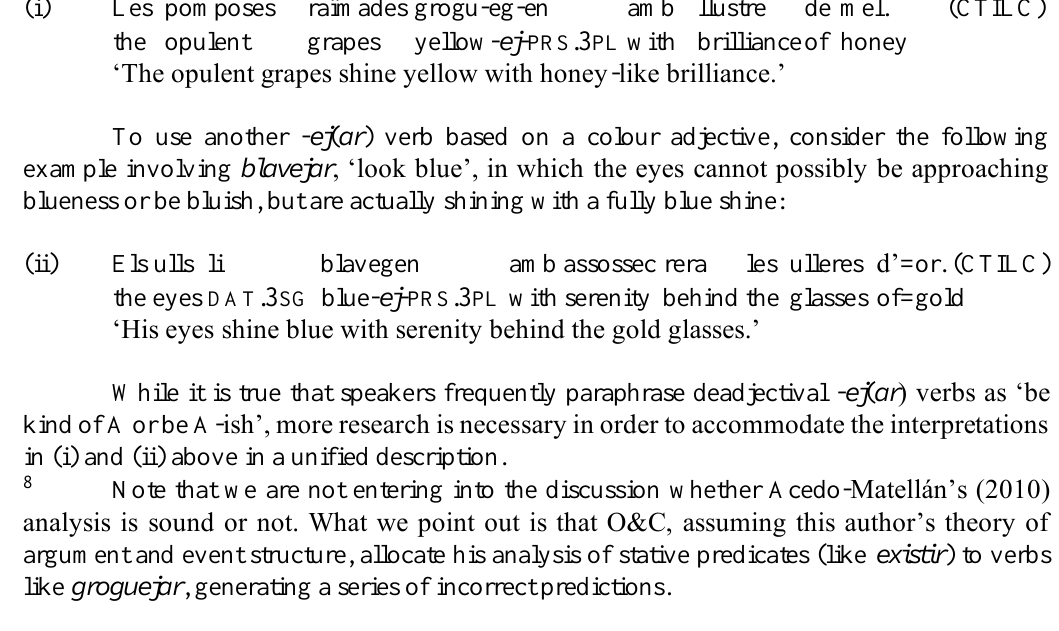
Els ulls li blavegen amb assossec rera les ulleres d’=or. (CTILC) the eyes DAT .3 SG blue- ej - PRS .3 PL with serenity behind the glasses of=gold ‘His eyes shine blue with serenity behind the gold